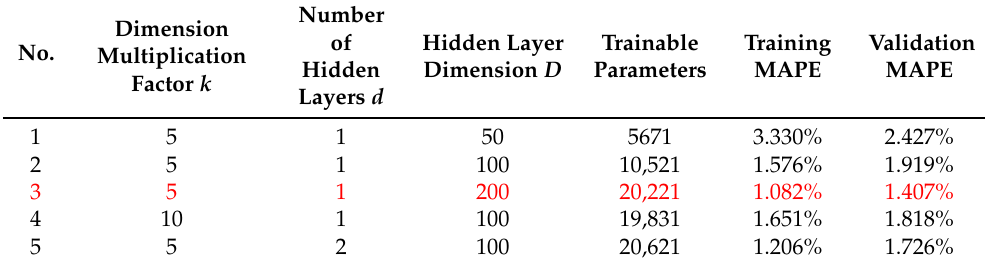
Table 2. Error comparison of different networks in model H 1 tuning tests. The network 3 (in red) is the final